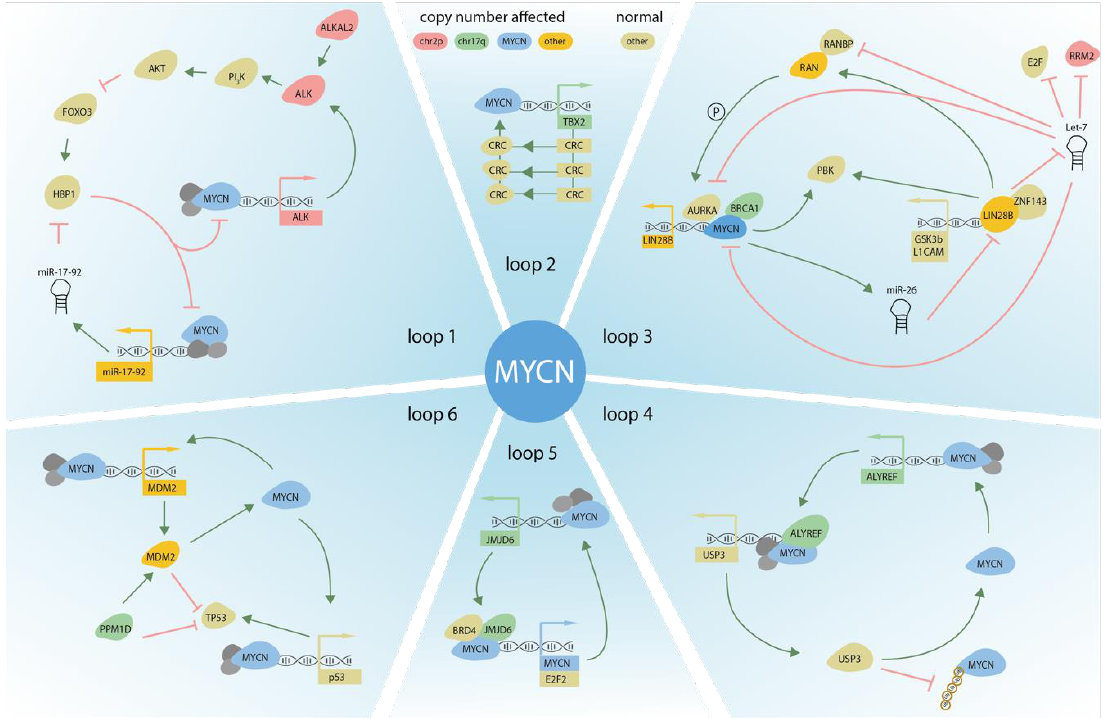
Figure 3. DNA copy number affected genes and their upstream and downstream regulators, supporting MYCN activity in NB. Six different autoregulatory loops are depicted. Color of the proteins (circles) or genes (square) indicates the genomic location of the CNA.